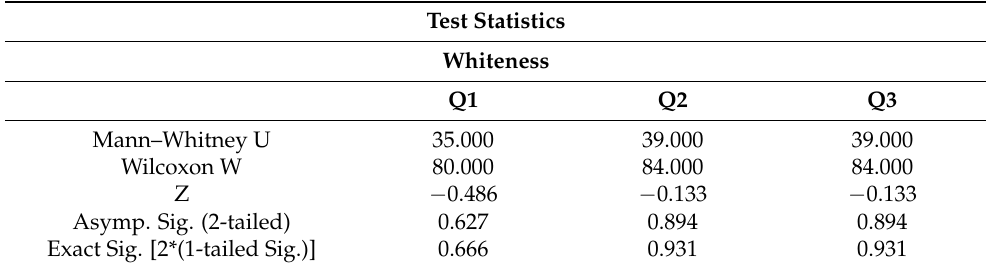
Table A5. Test statistics table of Mann–Whitney U test for the whiteness, according to the thickness.